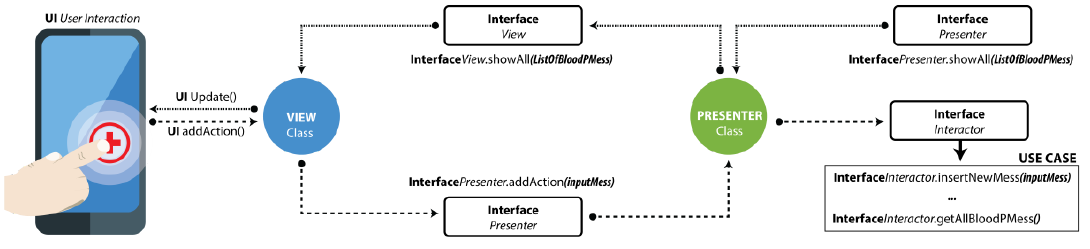
Figure 12. Presentation layer data flow.